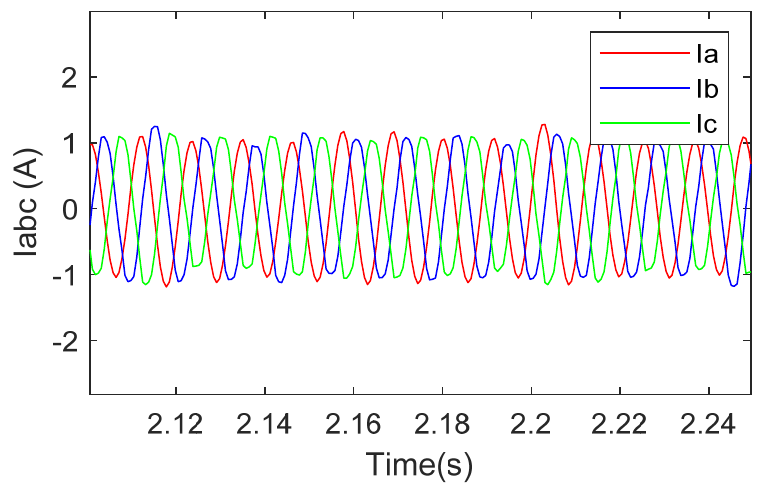
Figure 15. Zoom of the three-phase stator currents.